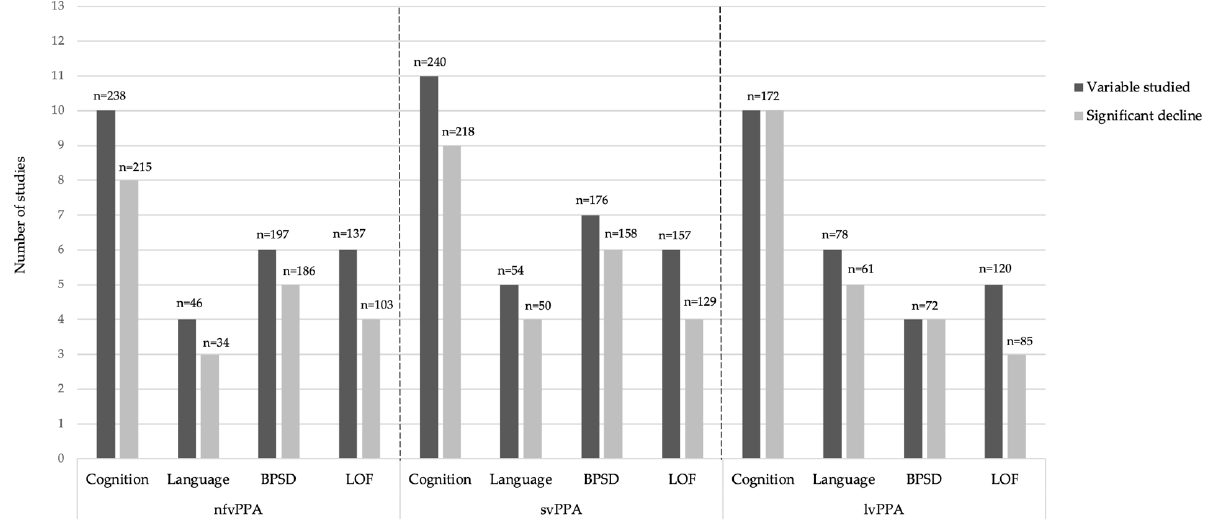
Figure 2. Summary of findings in 13 of the observational studies